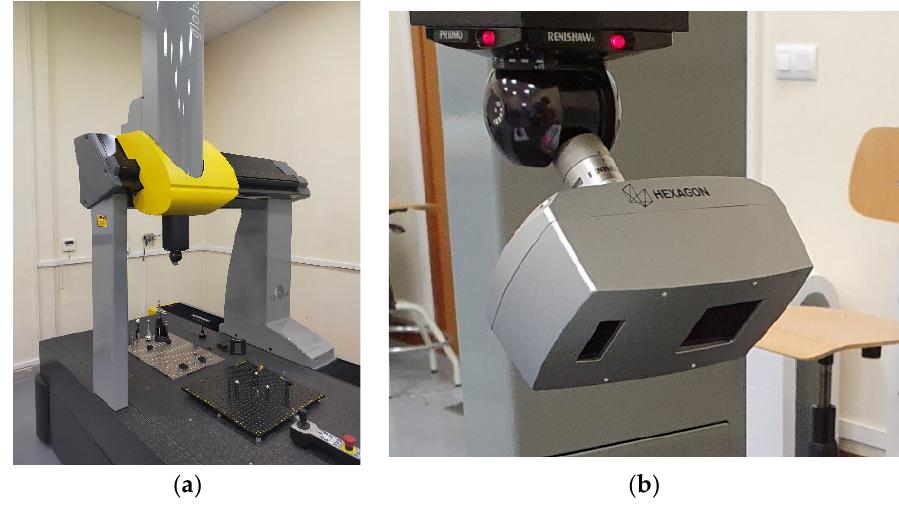
Figure 2. ( a ) coordinate measurement machine; ( b ) laser triangulation sensor.